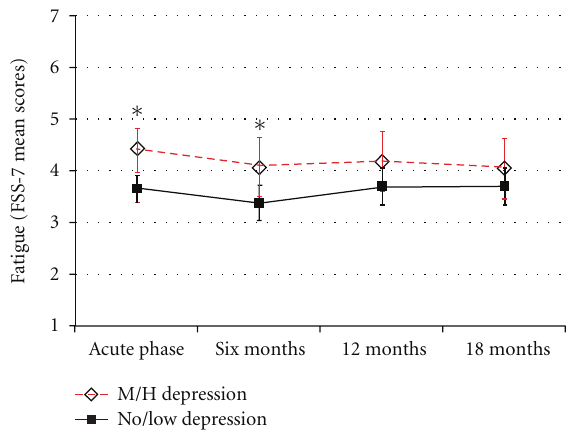
Figure 2: Time course for fatigue by patients with low depression scores ( n = 68) versus those with medium-high depression scores ( n = 26). Adjusted for level of physical functioning and prestroke fatigue. Bars are lower and upper 95% CI.